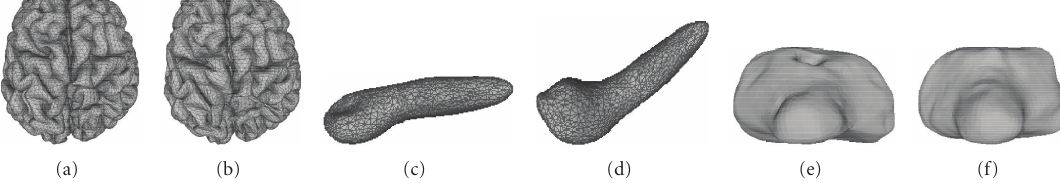
Figure 11: Reconstructed brain deformations using SHD approach: (a) is the initial brain shape and the circle marks one typical area under deformation, (b)–(e) are the reconstructed brain deformations.